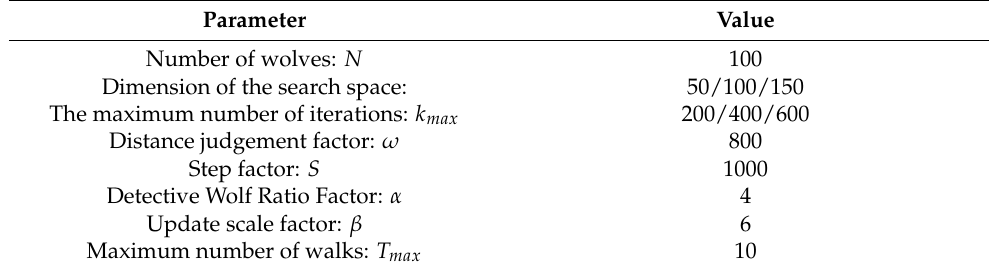
Table 3. Experimental parameter